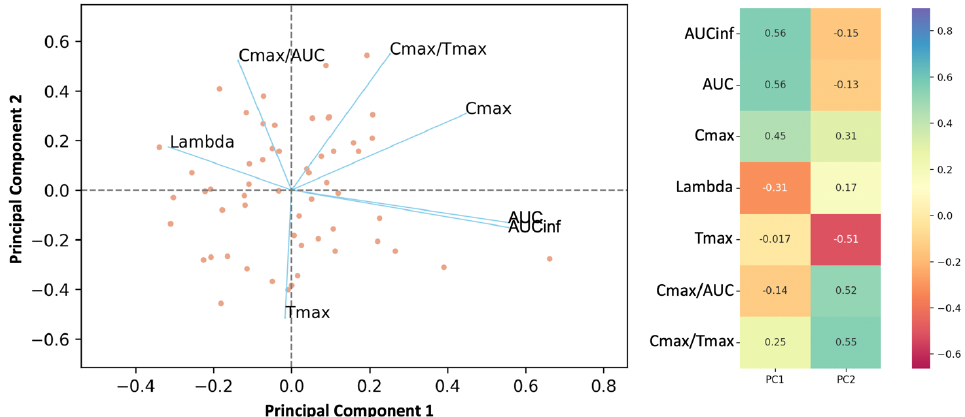
Figure 2. Principal component analysis of the pharmacokinetic parameters from the actual bioequivalence study. Left panel: Biplot of the two principal components showing the individual scores and the loadings (blue lines) of the pharmacokinetic parameters. Right panel: Loading values for the two initial principal components.